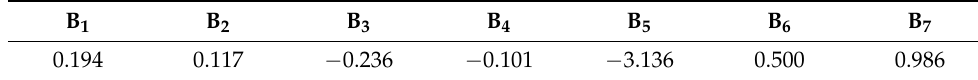
Table 9. Regression analysis results for various parameters.